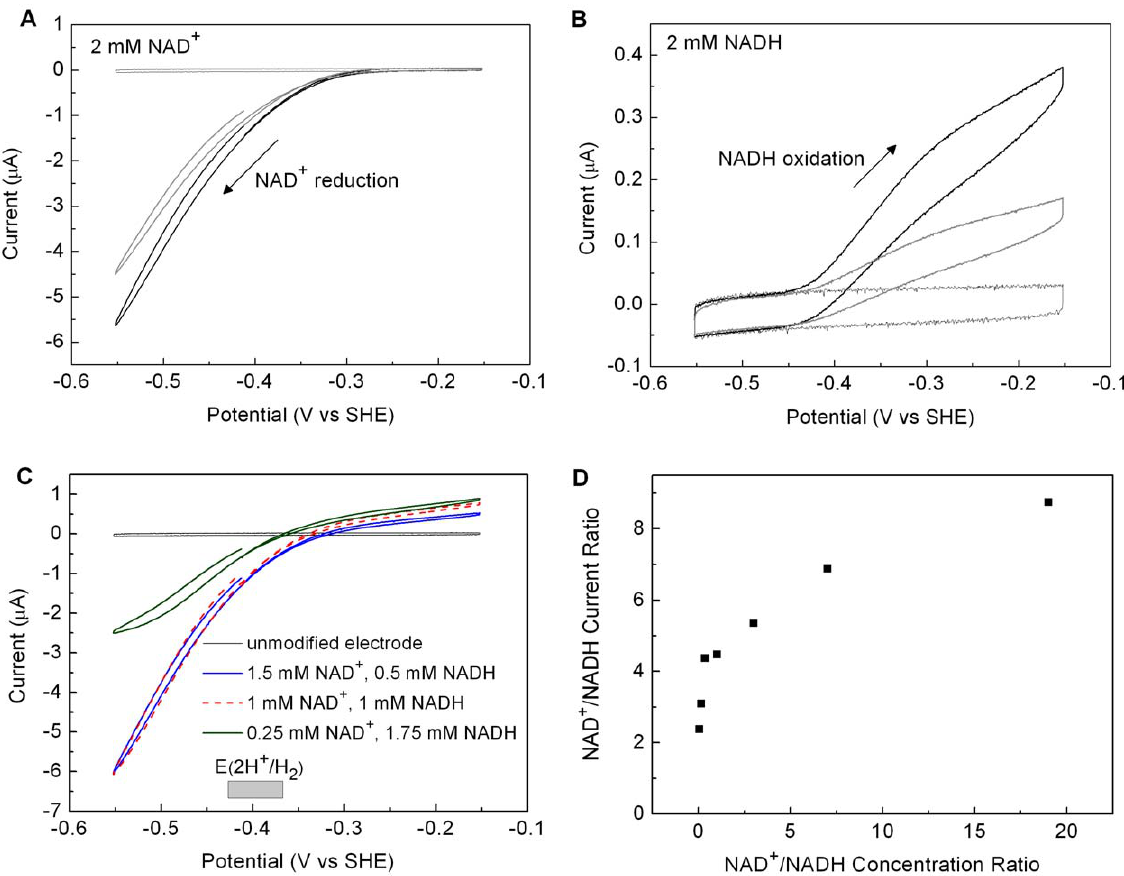
Figure 4. Cyclic voltammograms for an electrode modified with HoxFU recorded at different ratios of NAD + /NADH. (A) 2 mM NAD + ; (B) 2 mM NADH; (C) at concentrations as indicated. In panels A and B, the first (black) and second (gray) cycles recorded after preparing a fresh film on the electrode are shown. In panel C, only the first cycle is shown for each ratio of NAD + /NADH. Other conditions: Tris-HCl buffer (50 mM, pH 8.0) 30 u C, scan rate 10 mV/s, electrode rotation rate: 2500 rpm. In panel C, the shaded box indicates the range of potentials for E (2H + /H 2 ) at pH 8.0 and 30 u C between 100 nM and 10 m M H 2 . Voltammograms in A and C were commenced from 2 440 mV and in B were commenced from 2 550 mV, with the potential swept first towards more positive values. Panel D: average current magnitude at 140 mV more negative than E (NAD + /NADH) (NAD + reduction) over the current at 140 mV more positive than E (NAD + /NADH) (NADH oxidation) plotted against the ratio of substrate concentrations (2 mM total NAD + and